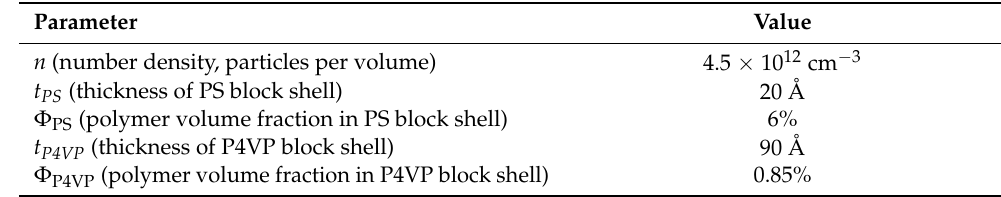
Table 7. The fitted parameters obtained from three fitting procedures of scattering data of